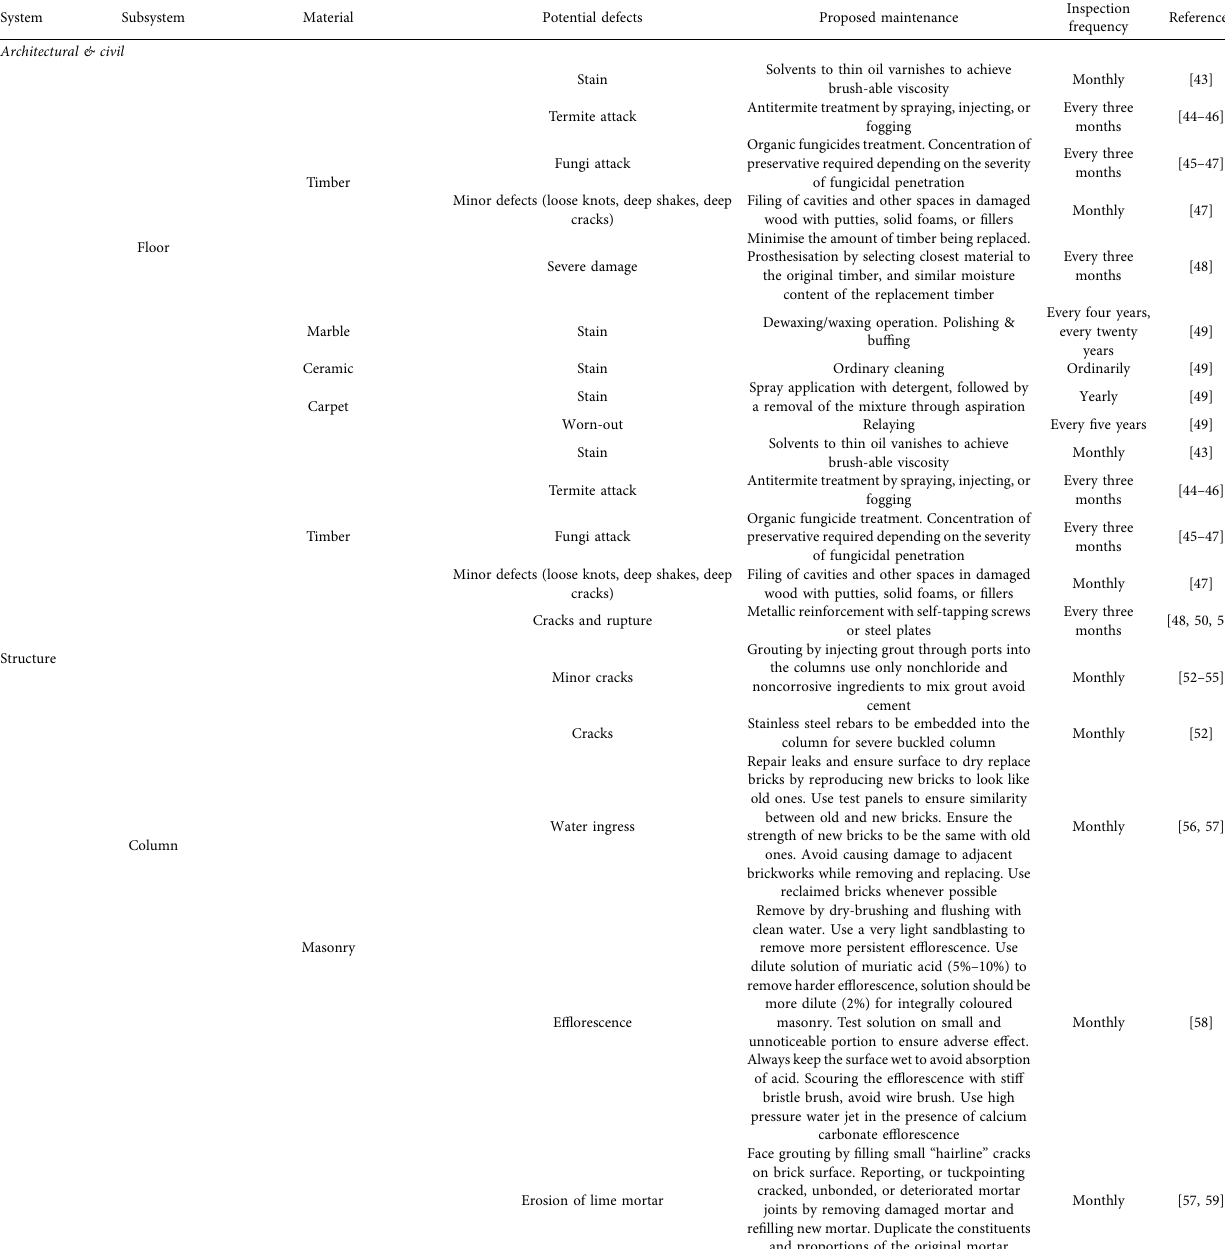
Table 2: Proposed maintenance guideline for Anglican churches in